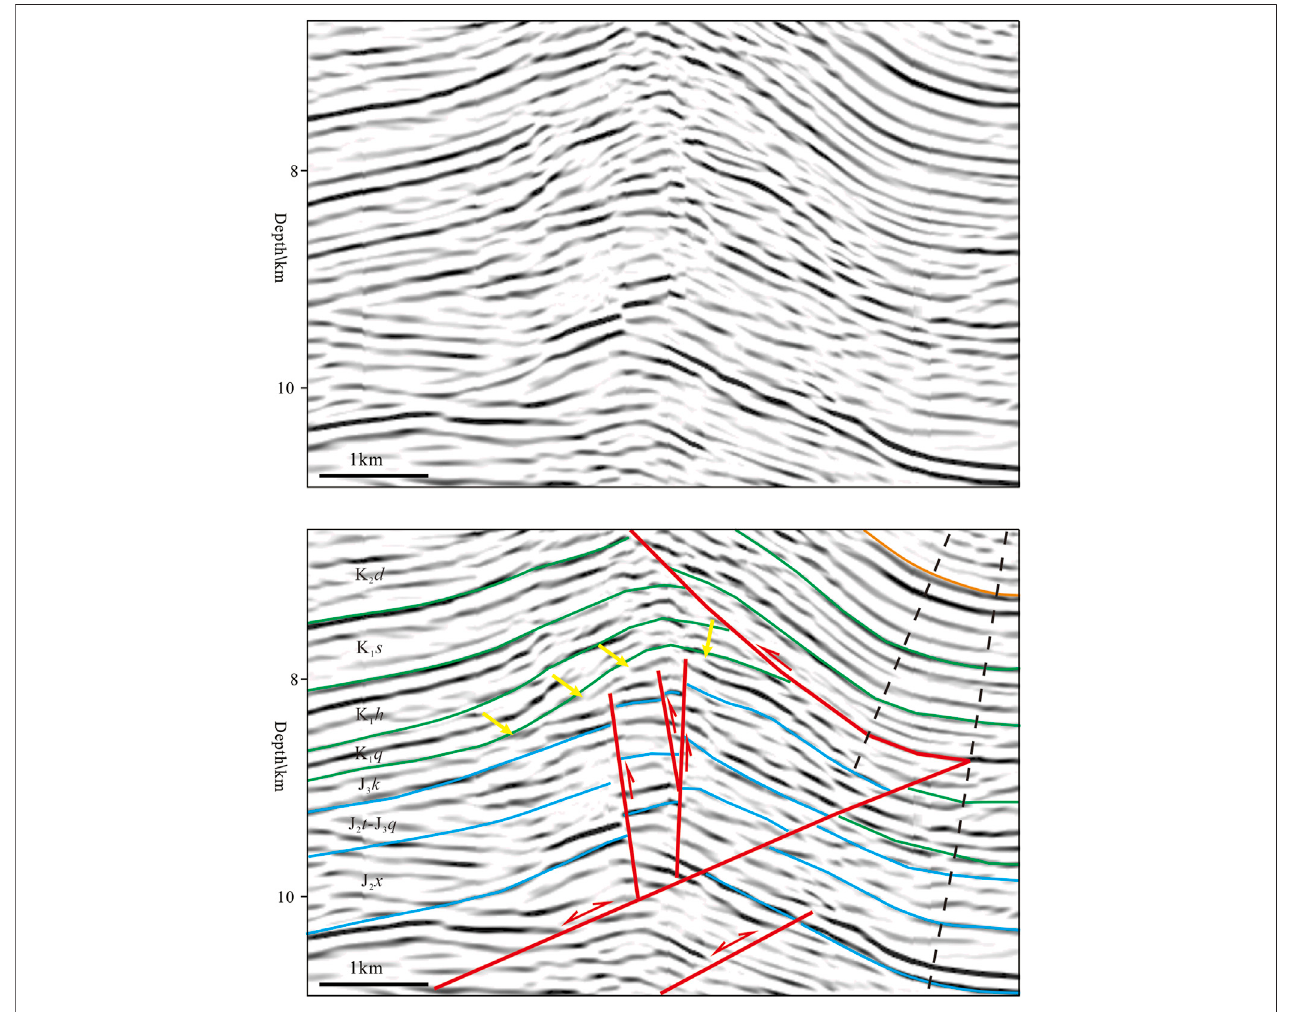
FIGURE 6 | Close view of the structural wedge in the Tugulu anticline, which clearly shows unconformity between the Jurassic and Cretaceous.